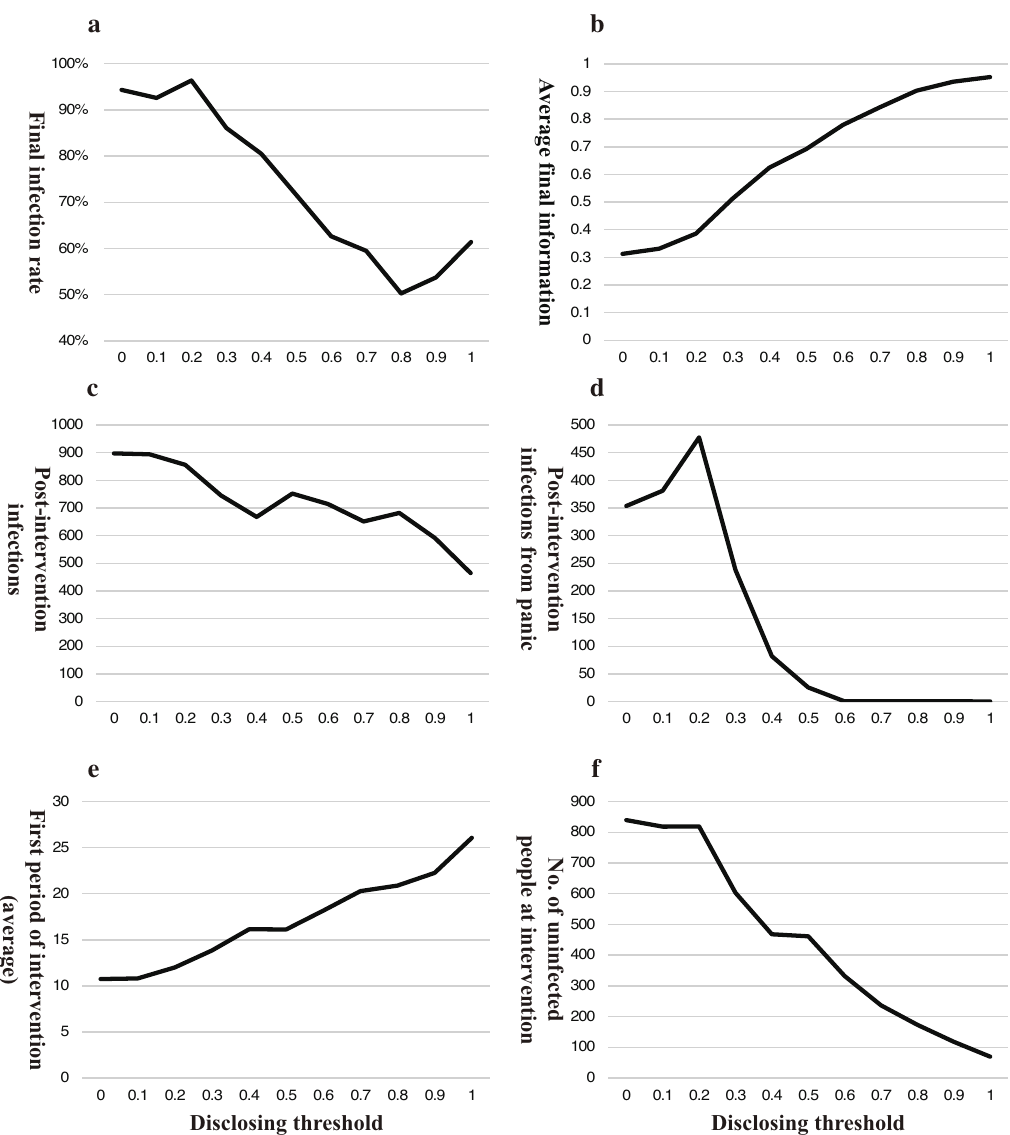
Figure 4. Simulation results for government’s trade-off in disclosing under the special case of ξ = 1, X I = 0.5. ( a ) depicts final infection rate; ( b ) conveys the impact of disclosing threshold on information; ( c , d ) represent the positive effective of a larger disclosing threshold by showing the new infections overall or from panic after government intervention; and ( e , f ) describe the negative effect by showing when the government intervenes and how many health people remained at